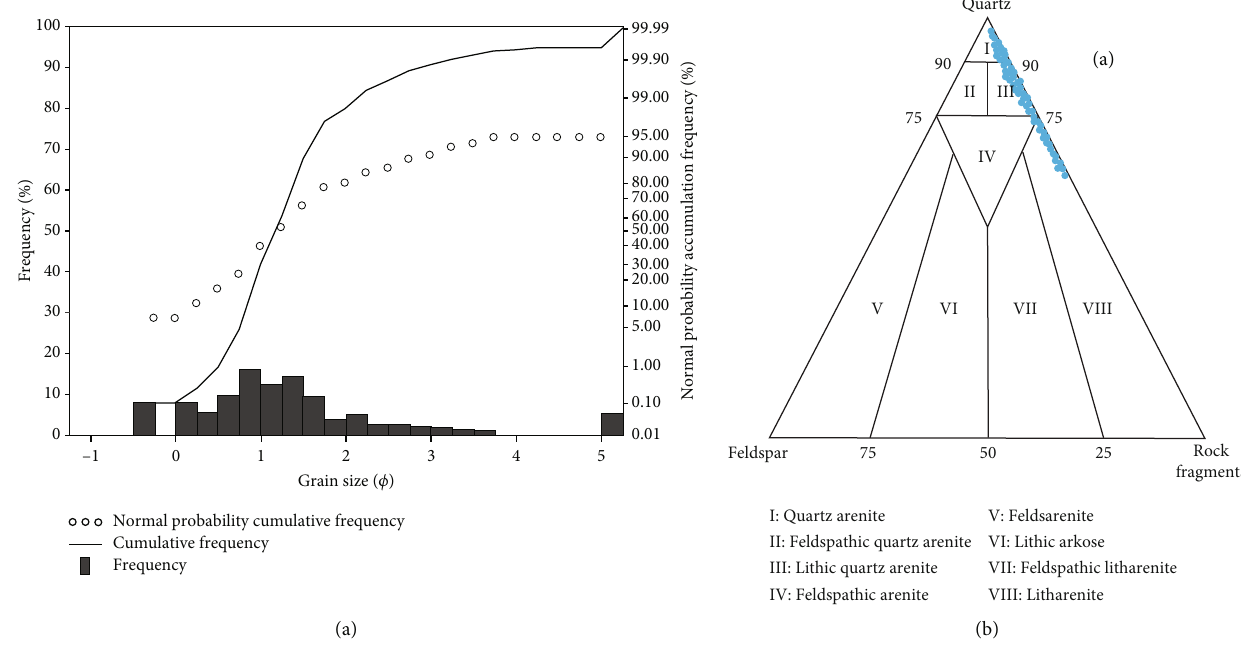
Figure 2: Grain size distribution and rock classi fi cation of Shan-2 Member in the Shanxi